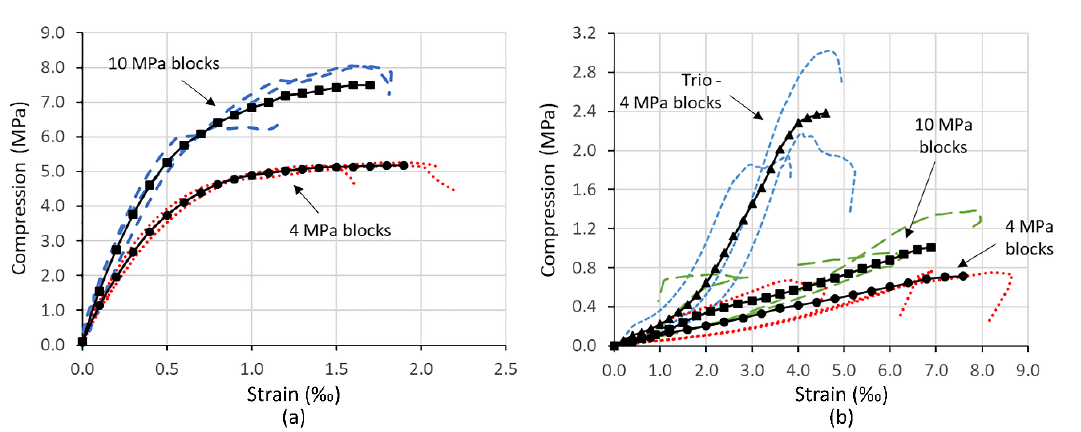
Figure 13. Stress-strain curves of small walls: (a) at room temperature; (b) after